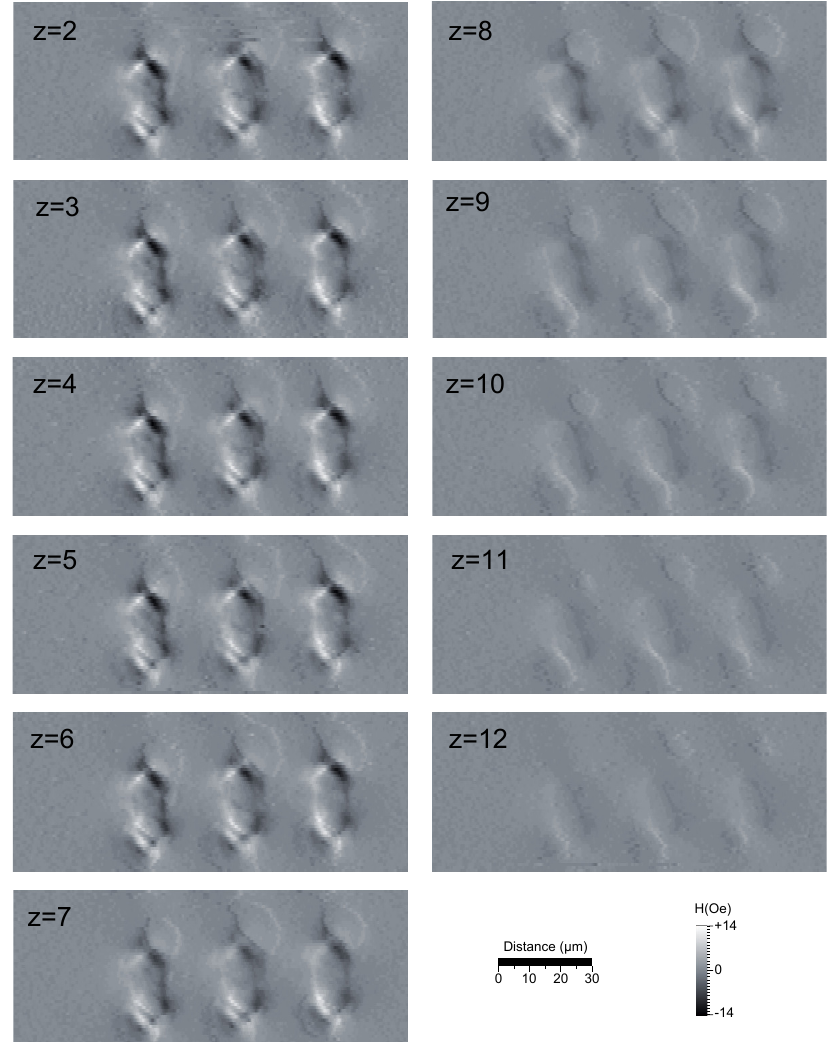
The data obtained when scanning a TMR sensor at varying heights below a three-bit tag and thereby measuring the stray field in a 50 × 150 × 10 µ m 3 volume. The sensitive axis is vertical, as seen in the figure, and the images are obtained from the real component of the signal. The z label of each image represents the distance from the sample in µ m. Frequency: 833 Hz, time-constant: 50 ms, scan speed: 40 µ